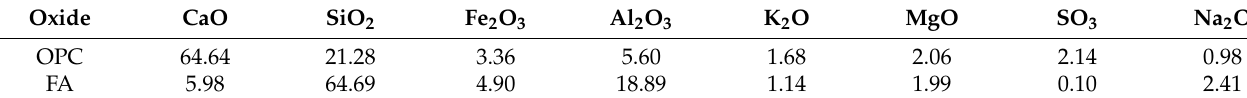
Table 2. Oxide composition of the OPC and FA used.